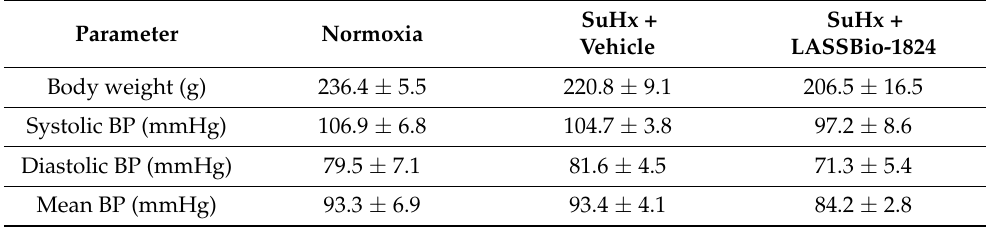
Data represent mean ± SEM ( n = 5 rats per group). BP, blood